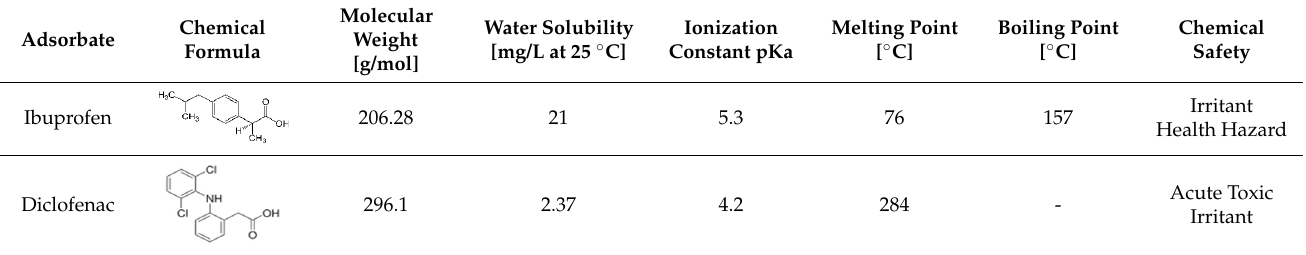
Table 1. The physicochemical properties of the studied adsorbates